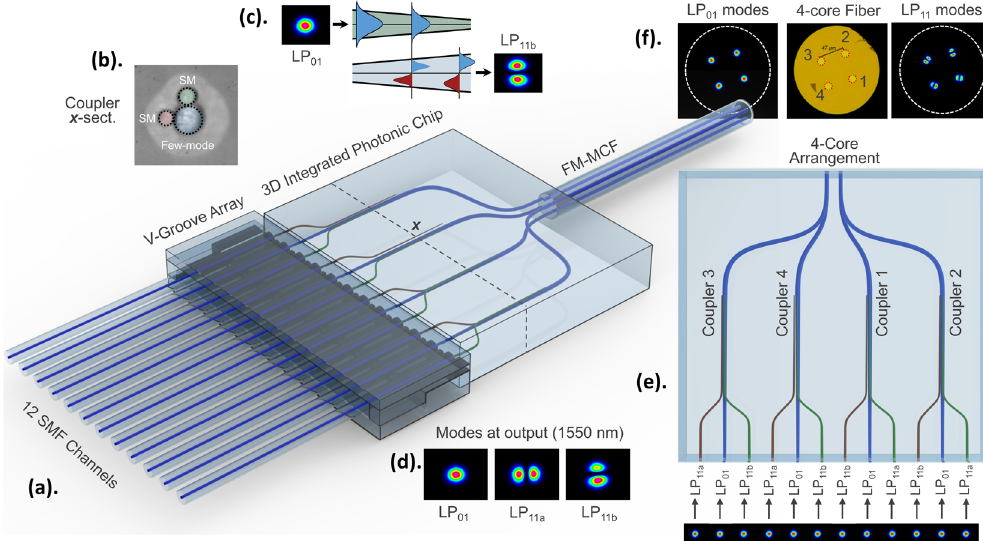
Figure 1. Fabricated integrated FM-MCF multiplexer. ( a ) The FM-MCF multiplexer consists of 4, 3-core tapered mode couplers. ( b ) Each 3-core tapered coupler consists of an up-tapered few-mode waveguide (highlighted in blue) surrounded by two down-tapered single-mode waveguides (highlighted in red and green) with a 90 degree angular offset to allow for multiplexing both the LP 11a and LP 11b modes in the few- mode waveguide. Shown is a microscope image of one coupler’s cross-section at position x (prior to thermal annealing). With post-annealing of the glass the large outer index modification (light grey region) is erased 44 . The adiabatic mode evolution in such a coupler is demonstrated in ( c ) and the LP 01 , LP 11a and LP 11b modes of one of the cores imaged using an infrared camera are shown in ( d ). After the coupling region the few-mode waveguides ( e ) fan-in to interface with the ( f ) 3-mode, 4-core fiber allowing each individual mode to be excited